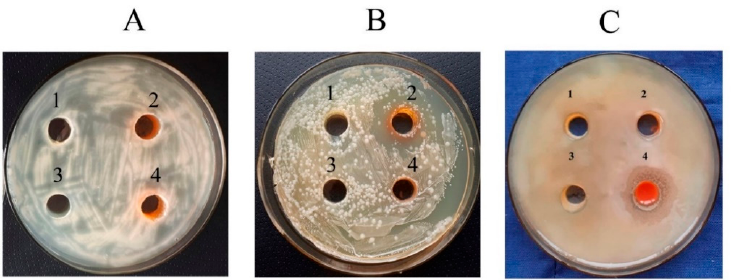
Figure 7. Effect of the Se NCs on the growth of rhizosphere bacteria (with 105.57 µg/mL for